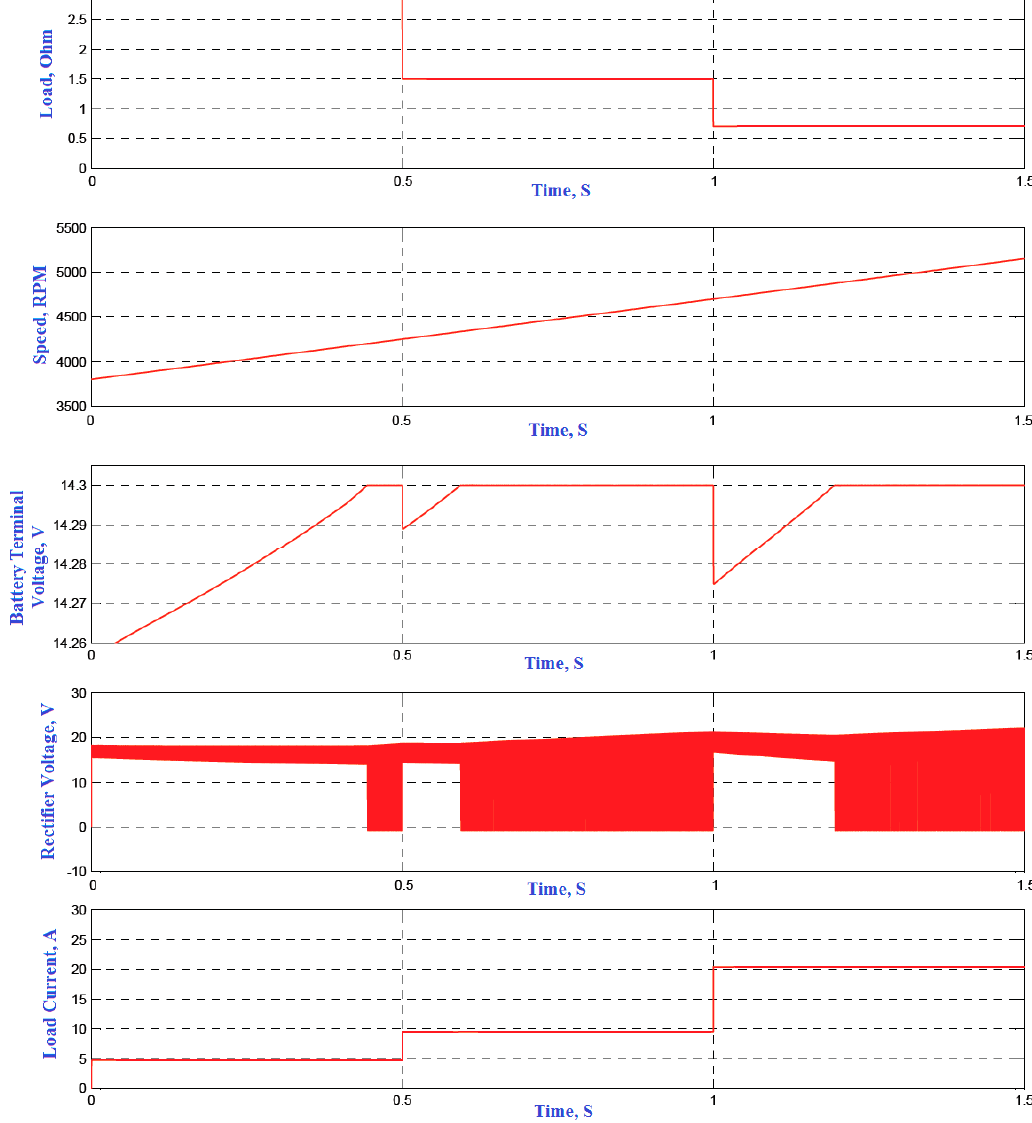
Figure 18. Simulation results for variable speed and variable electrical load.